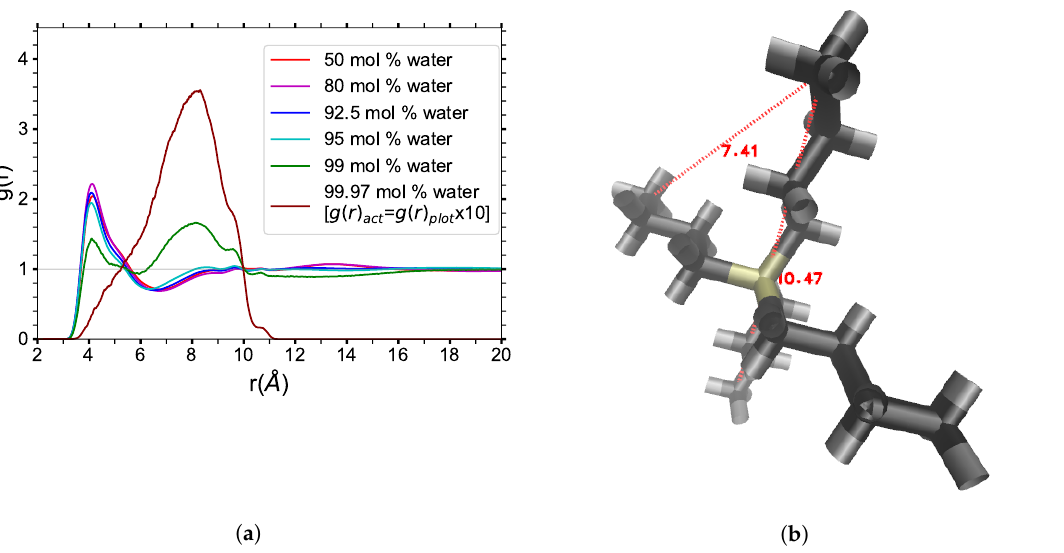
Figure 5. ( a ) Radial distribution functions of the end carbons on the TBP’s butyl chains (C TBPH–water solution at 300K: Note that the 99.97mol% water data is an order of magnitude higher than the other data since it was scaled down by 1/10 to fit on the same plot; ( b ) Radial distances of the end carbons on the TBP’s butyl chains (C